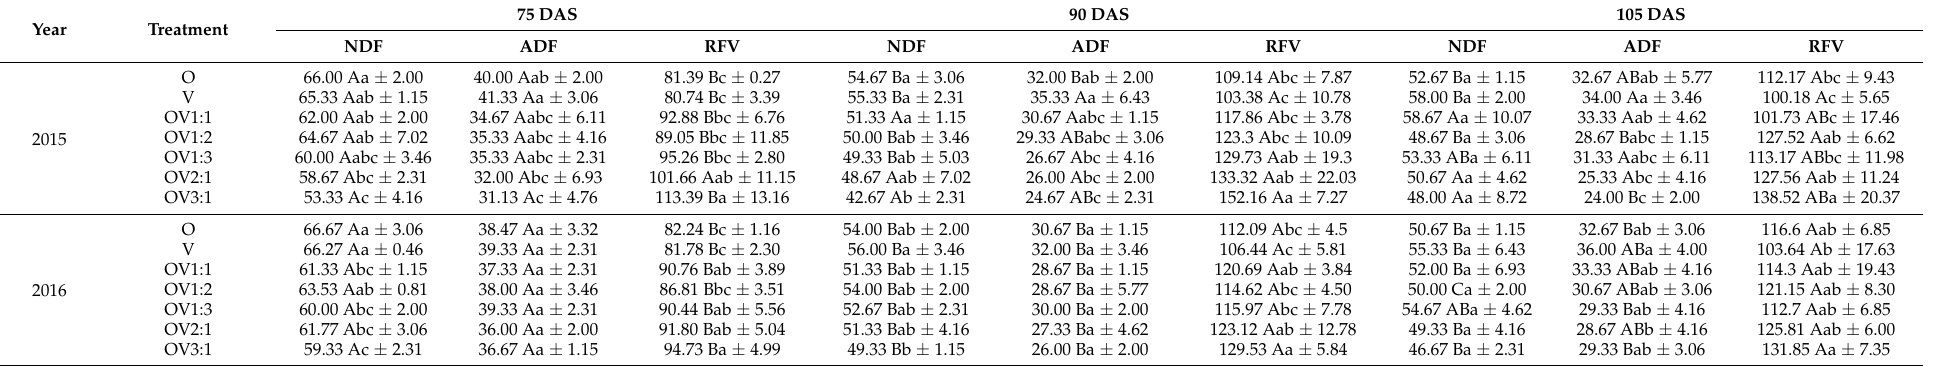
Table 6. Acid detergent fiber fraction and neutral detergent fiber fraction of oat and common vetch at different days after sowing in